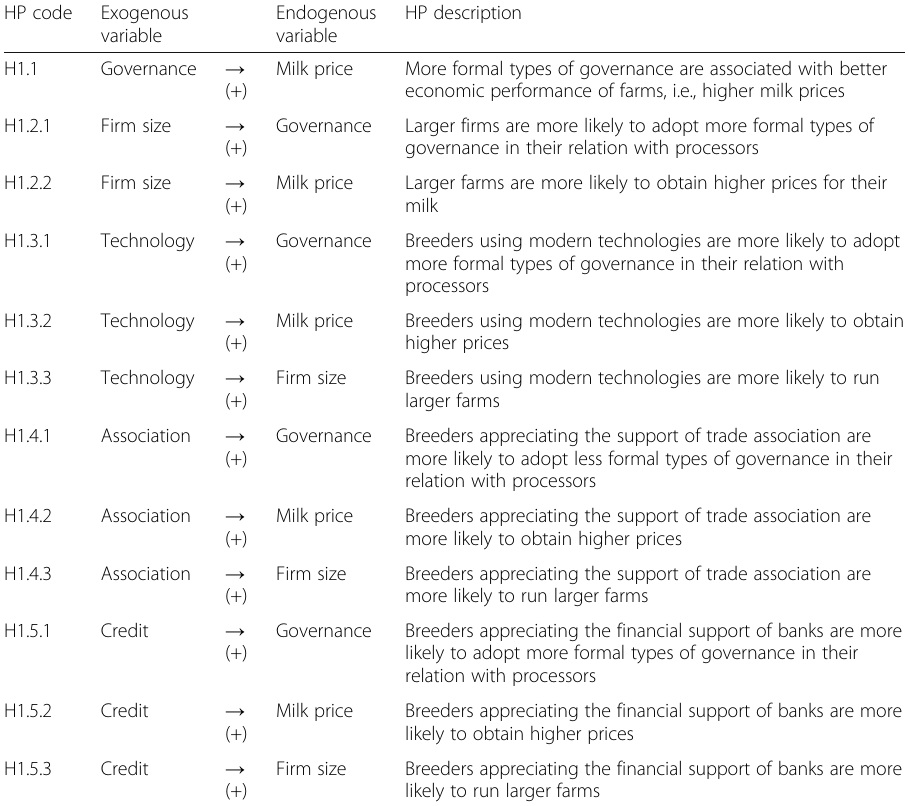
Table 1 Research hypotheses investigating the effects of environmental conditions on relational governance and firm economic